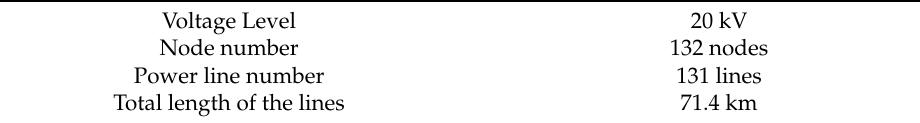
Table 4. Specifications of the test system.